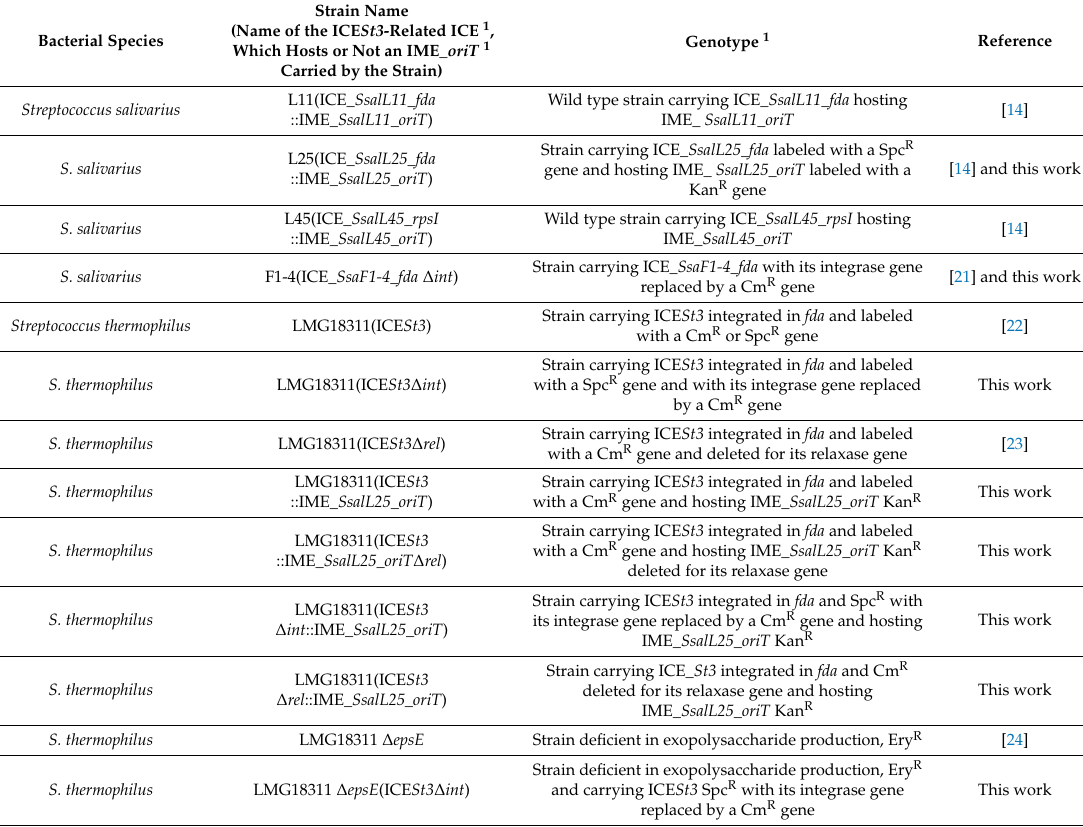
Table 1. Characteristics of the strains used in this